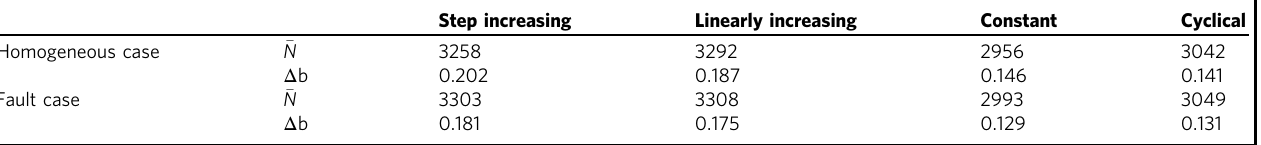
Table 1 Statistics on the different injection strategies without and with a